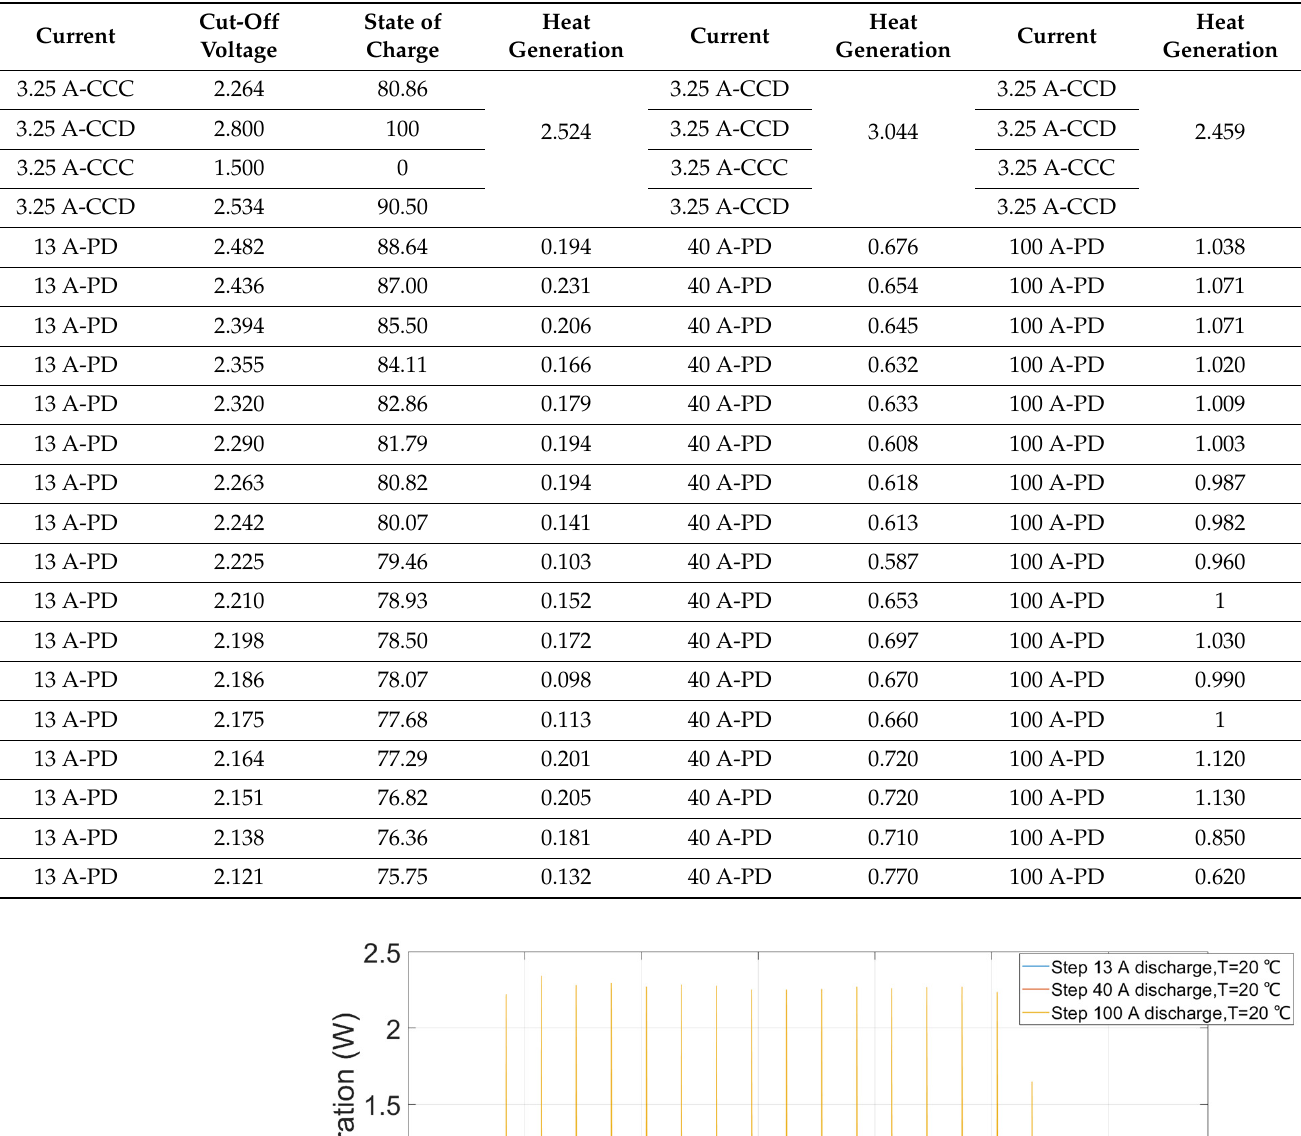
Table 3. Test matrix for Case B.